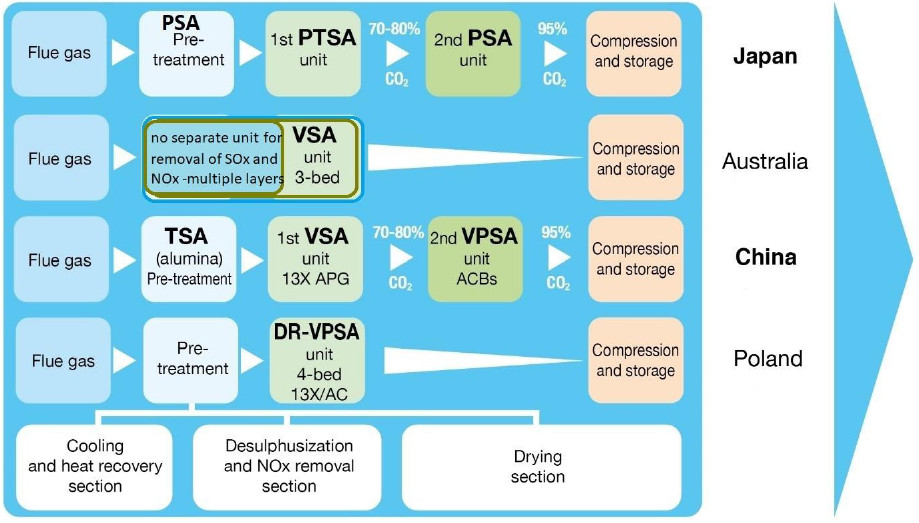
Figure 1. Pre-treatment sections in global pilot adsorption CO 2 capture units (PTSA: pressure temperature swing adsorption; PSA: pressure swing adsorption; VSA: vacuum swing adsorption; VPSA: vacuum pressure swing adsorption; DR-VPSA: dual-reflux vacuum pressure swing adsorption).